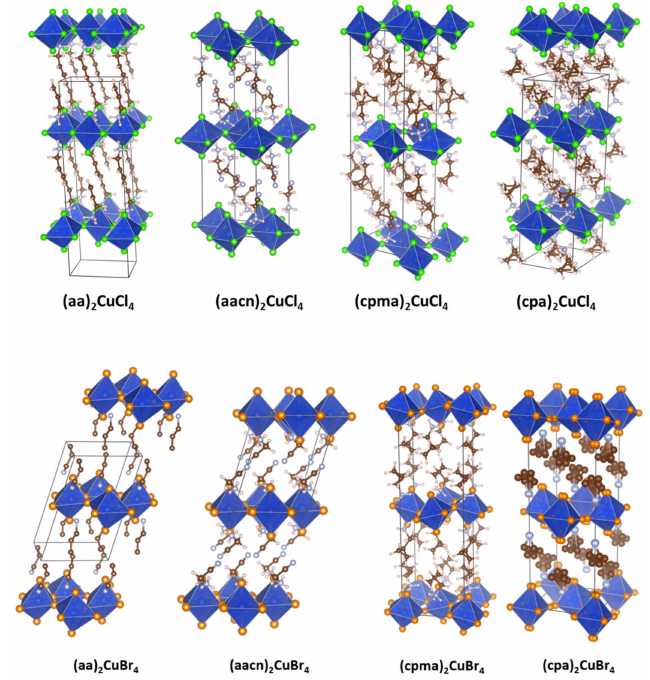
Figure 1. Packing in the crystal structures of ( top ) alkylammonium tetrachlorocuprates(II) and ( bottom ) alkylammonium tetrabromocuprates(II) prepared in this work. Unit cell is highlighted with black lines. Centers of blue octahedra are occupied with copper ions. Chloride and bromide ions are drawn as green and orange spheres, respectively. Carbon, nitrogen and hydrogen atoms are presented as brown, light blue and gray spheres, respectively. The anions pack in layers of corner-sharing octahedra, while the cations form a bilayer between the inorganic layers, akin to hybrid Ruddlesden-Popper